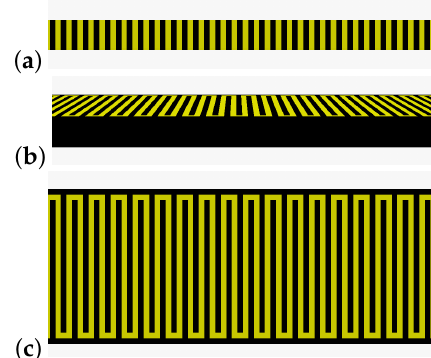
Figure 7. Schematics showing the cross-sectional side view ( a ), a low-angle perspective ( b ), and a top view ( c ) of a stacked DEA structure with alternating layers of conductive (black) and dielectric (yellow) PDMS. Note that the image is not to